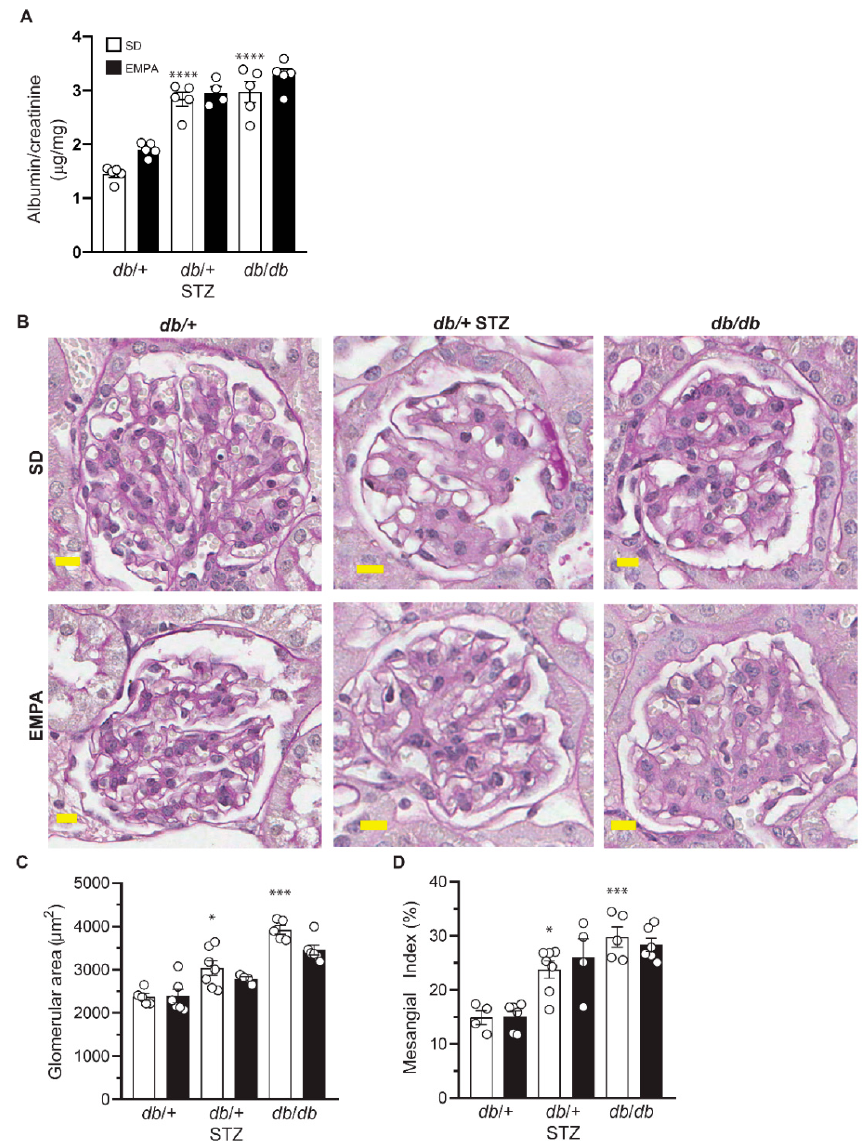
Figure 4. EMPA does not improve nephropathy in T1D and T2D mouse models. ( A – D ) Albumin-to-creatinine ratio (ACR) ( A ), representative examples of glomerular periodic acid-Schiff (PAS) staining ( B ), glomerular area ( C ), and mesangial index ( D ) in T1D ( db /+ STZ), T2D ( db / db ), and control ( db /+) mice with/without EMPA; n = 4–10 mice per group; * p < 0.05, *** p < 0.001, **** p < 0.0001 for untreated control vs. untreated T1D and T2D; by one-way ANOVA. Data are expressed as the mean ± s.e.m.